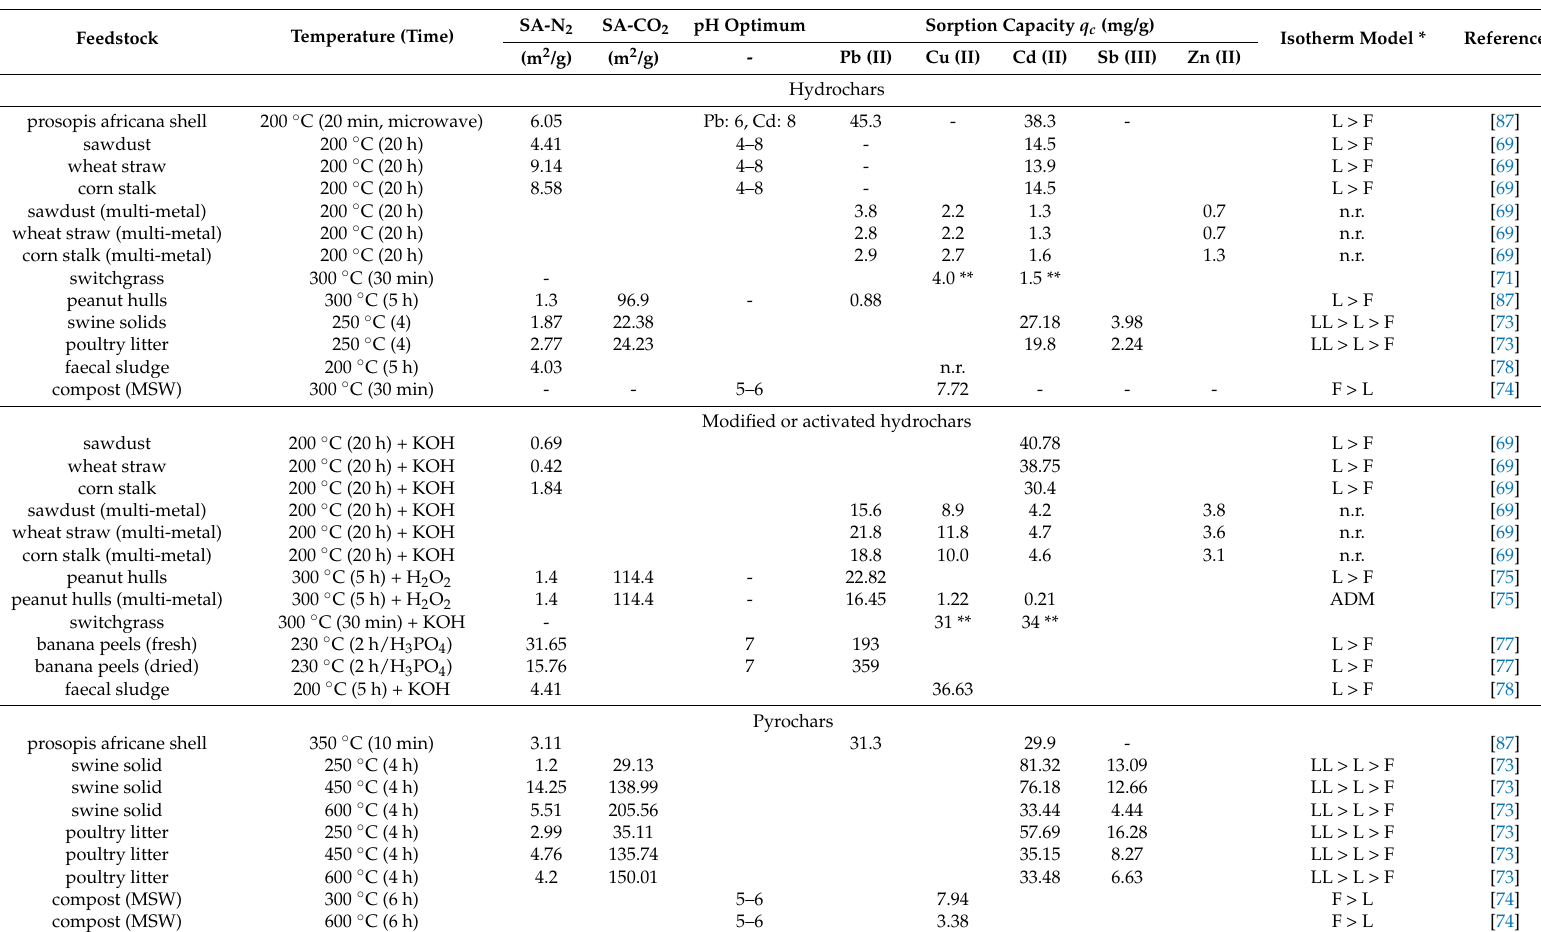
Table 3. Comparison of sorbent characteristics (maximum sorption capacities q c , surface area SA) for heavy metals and various hydrochars, modified or activated hydrochars and